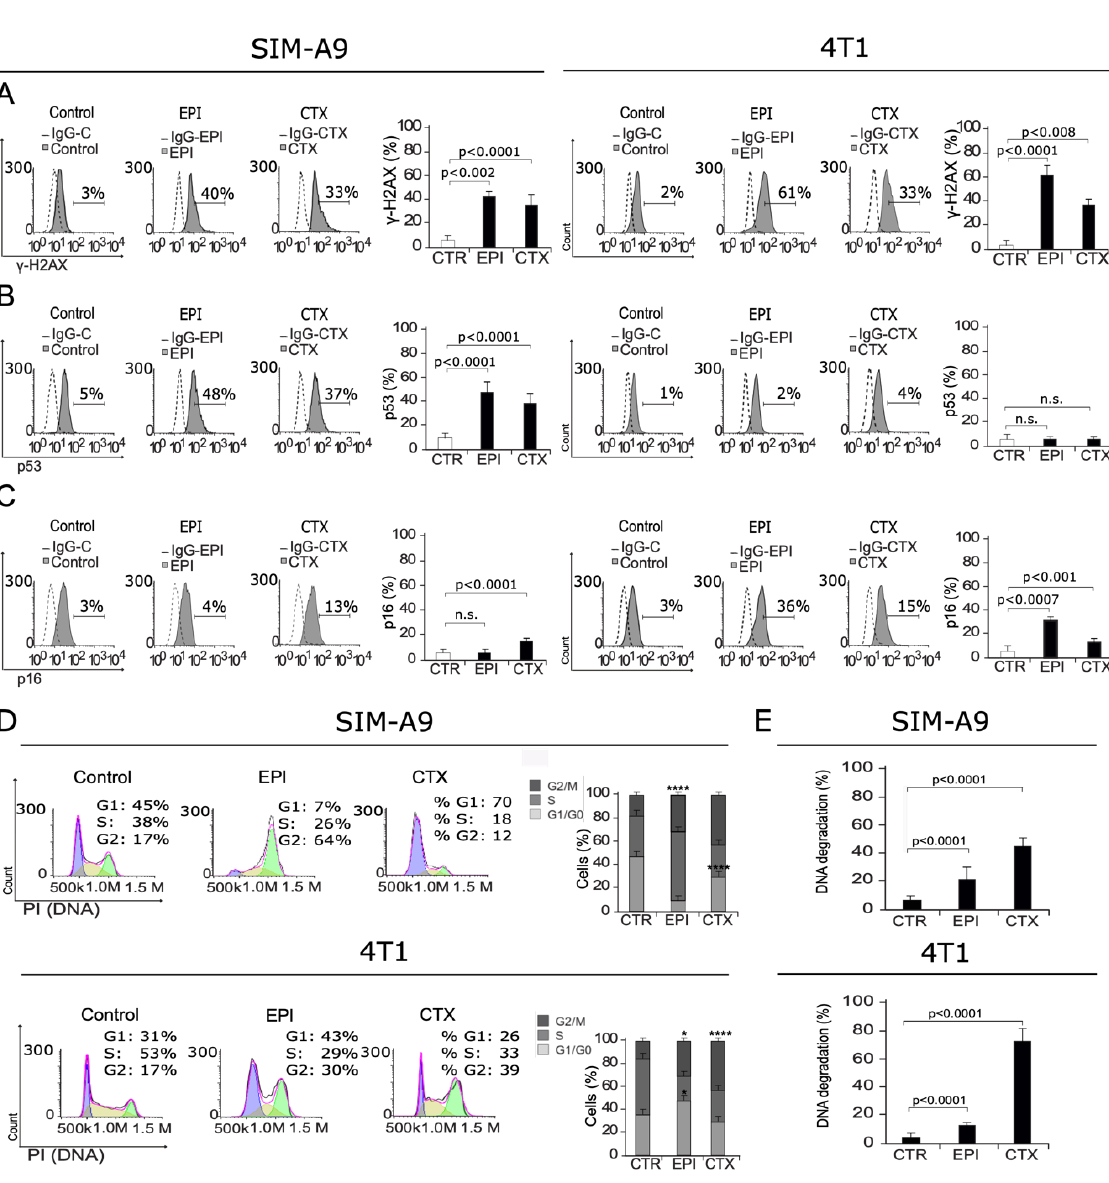
Figure 2: DNA damage and cell cycle arrest. SIM-A9 and 4T1 cells were treated for 24 h with CC 50 of EPI or CTX and assessed by flow cytometry. Representative histograms of nuclear damage analysis and quantification measured through A ) γ-H2AX assessment, B ) p53 expression, C ) p16 expression, and D ) Cell cycle analysis. Bars at right represent the mean  SD. E ) DNA degradation was evaluated using propidium iodide (PI) staining as in D, and SubG1 population was analyzed and mean (  SD) was presented in bar